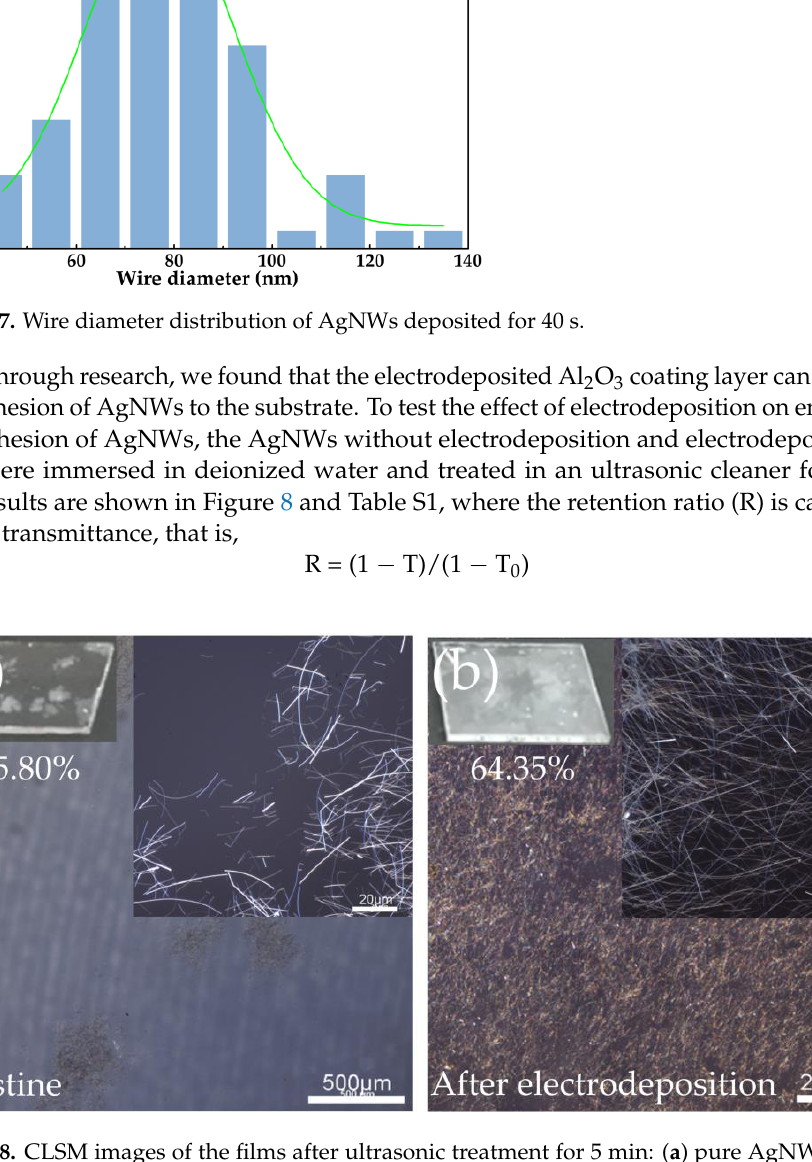
Figure 6. Ag3d XPS spectra before and after heat treatment at 250 °C for 30 min: ( a ) pure AgNWs and ( b ) AgNW – Al 2 O 3 composite film.